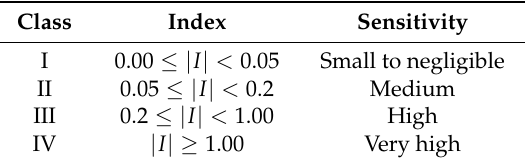
Table 3. Sensitivity index